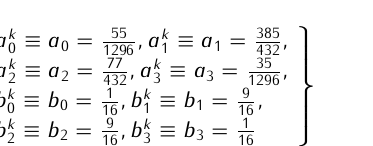
Theorem The 4-point ternary non-stationary scheme con- verges and has smoothness C 2 . Proof . Following [5], the theory of asymptotic equivalence is used to investigate the convergence and smoothness of the scheme (17). For proof see